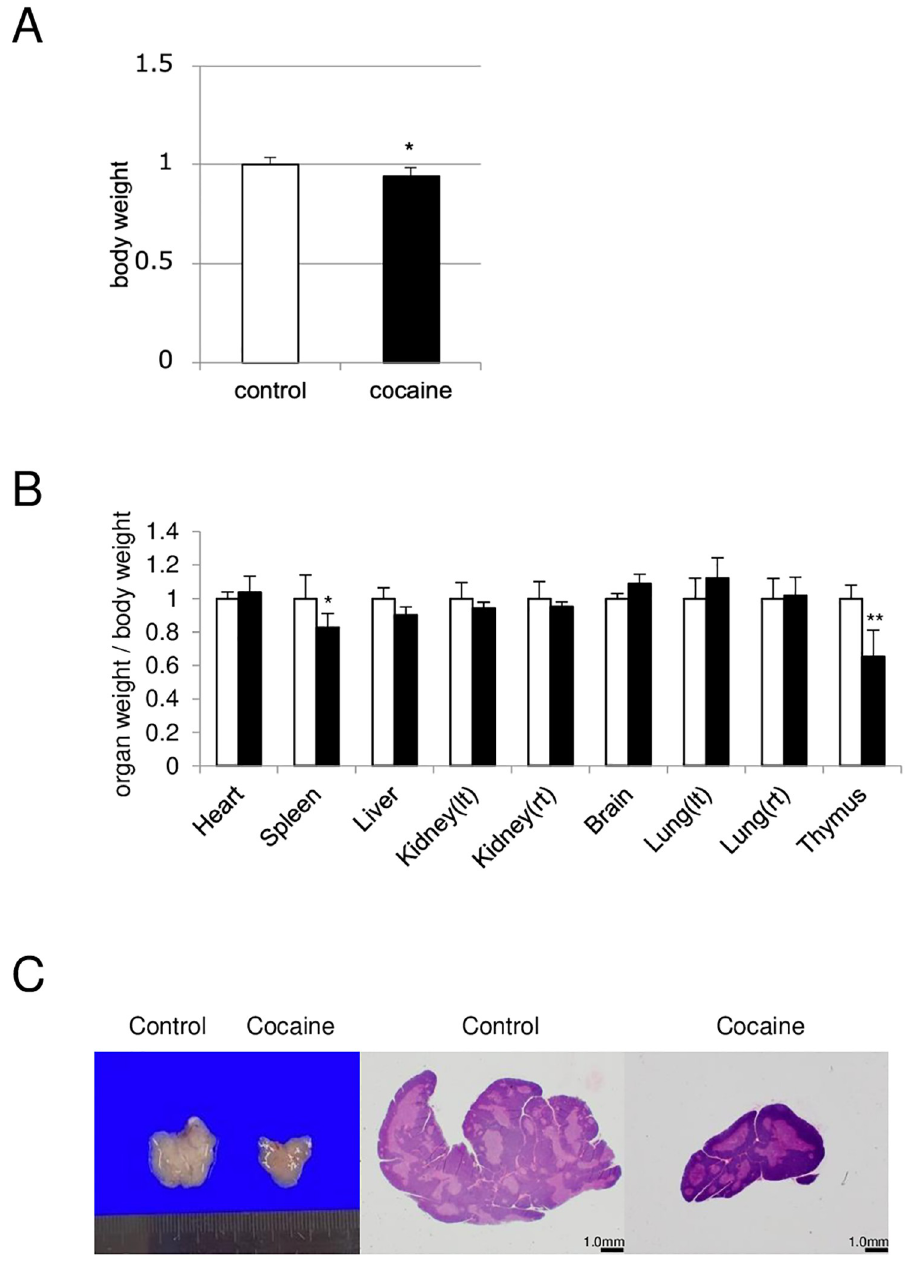
Fig 1. Reduction of thymic weight and size in rats administered cocaine. Rats were treated with or without cocaine (20 mg/kg/day, 7 days). (A) Loss of body weight in rats administered cocaine. (B) Changes in relative weights of major organs in rats administered cocaine. Lt, left. Rt, Right. For the graphs in (A) and (B), mean relative weights of the control group were set to 1. (C) Reduction of the thymic size in rats administered cocaine. Light microscopic and H&E staining images of thymus in rats administered cocaine are shown. Graphs show mean and S.E. �� P < 0.01, � P < 0.05 versus control.